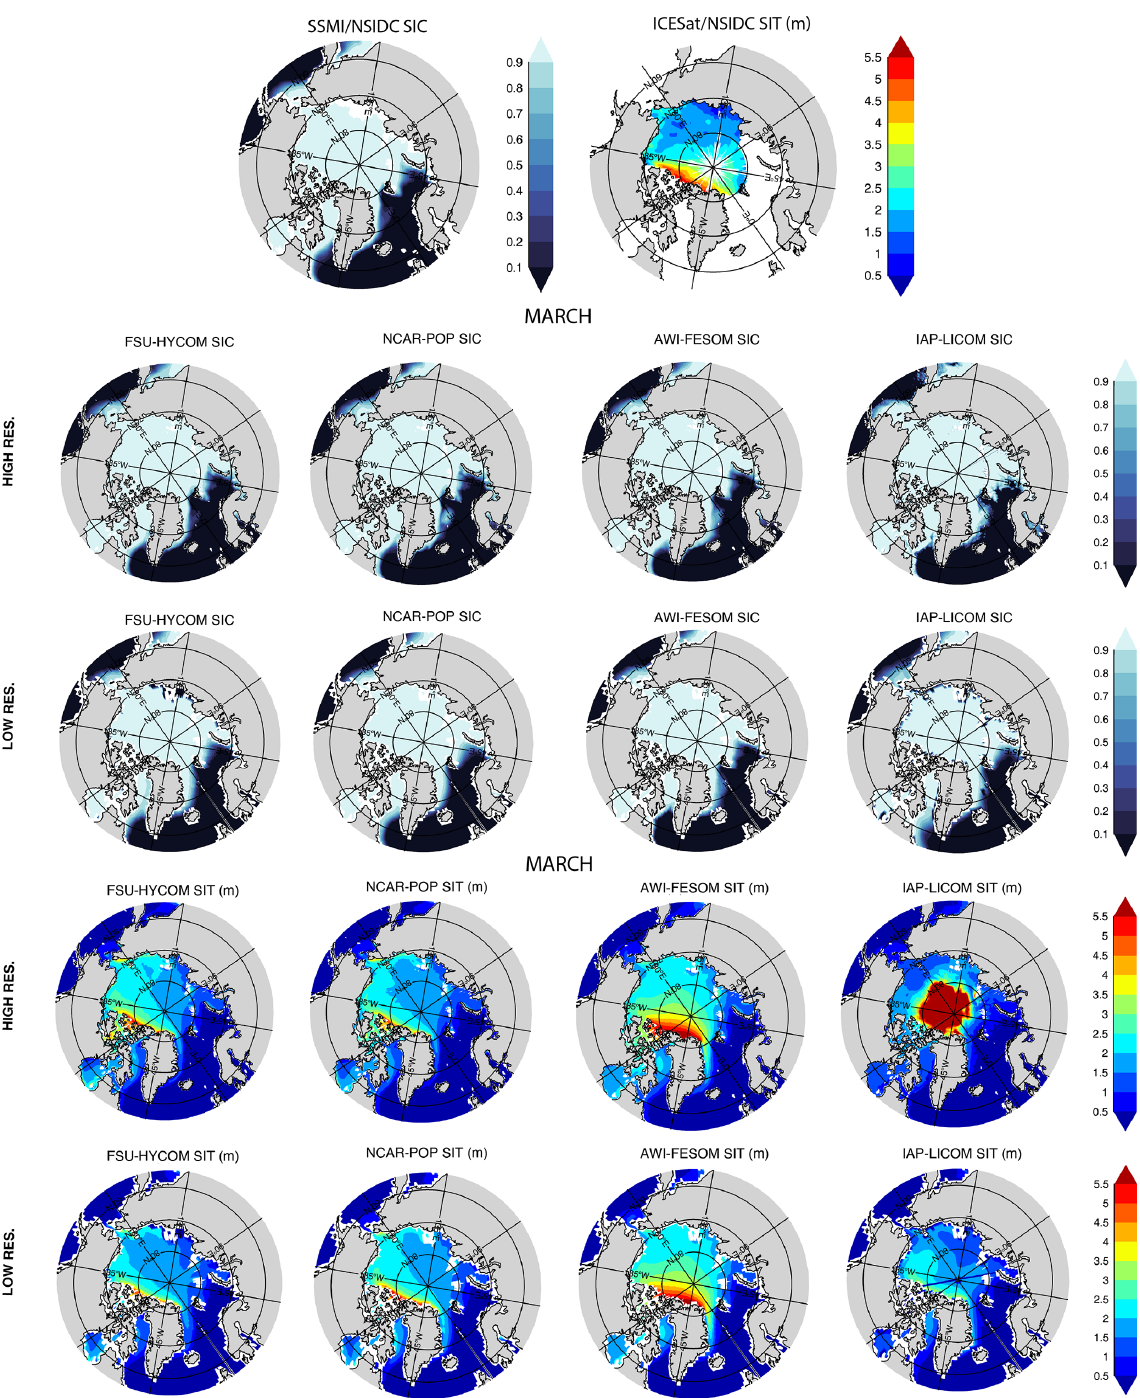
Figure 29. Northern Hemisphere winter mean (March) sea ice concentration (SIC) and thickness (SIT). Top panels: 1980–2018 SIC from passive microwave satellites and 2003–2007 SIT from ICESat. Lower panels: 1980–2018 modeled SIC and SIT.